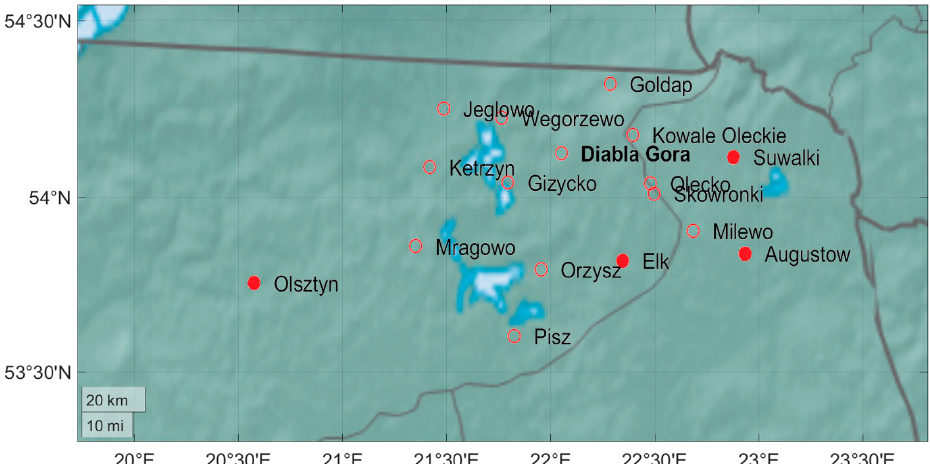
Figure 2. A zoom-in of north-eastern Poland with Diabła G ó ra denoted with bold font. Denoted are also other communities and towns in the near-region area within 100 km of Diabła G ó ra, which have relatively large emissions of SO X , NO X and / or PM 10 according to the emission inventory by GIO´S (2019) [50]. Towns with populations larger than 30,000 people are denoted with filled circles.